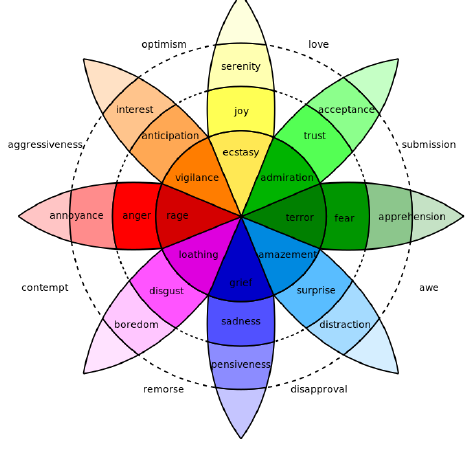
Figure 2. The Wheel of Emotions by Robert